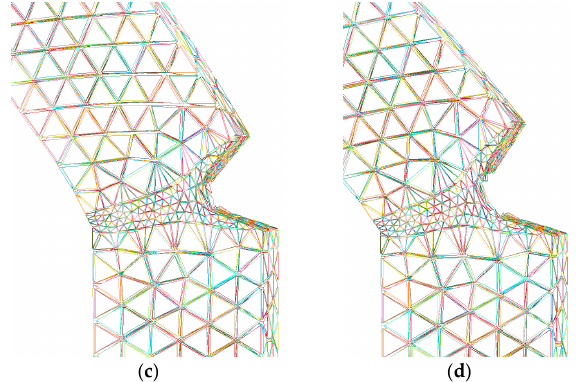
Figure 10. Fracture process of the specimen with 60 °C mold temperature: ( a ) 1.54 ms; ( b ) 4 ms; ( c ) 5.8 ms; ( d ) 7.8 ms. Table 1. Fracture energies of numerical simulations and experimental tests. Mold temperature (°C) Method